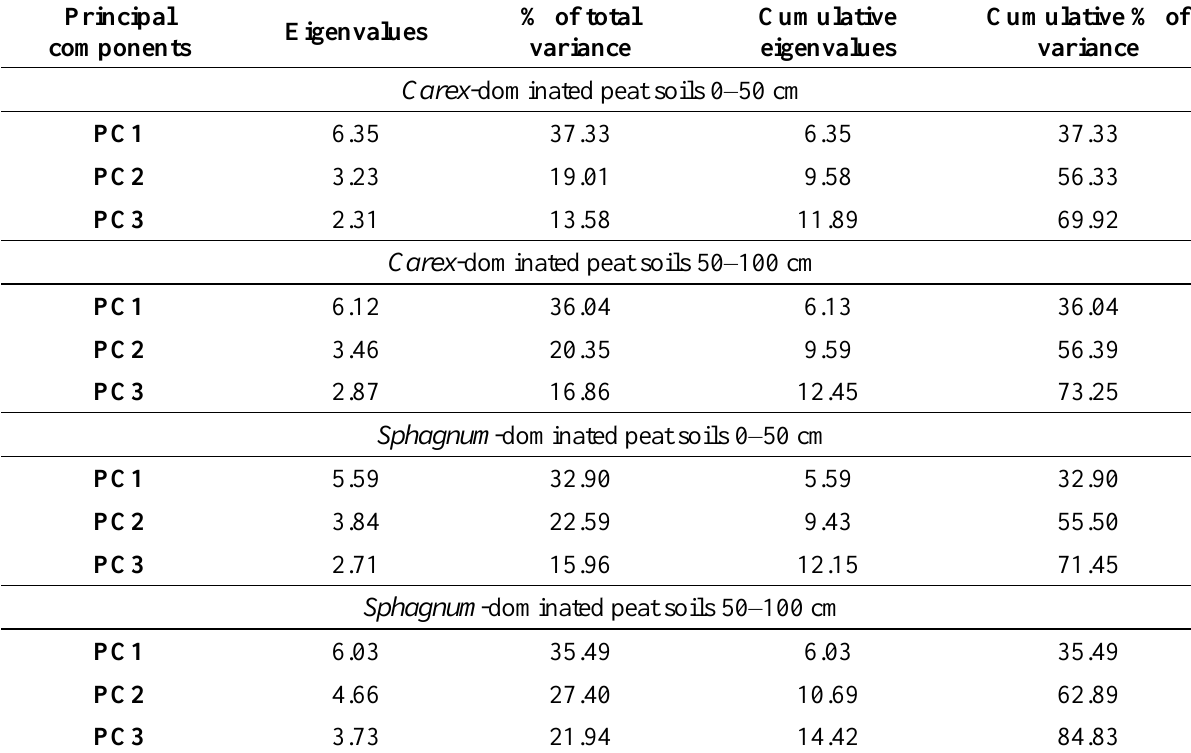
Table 4. Results of the principal component